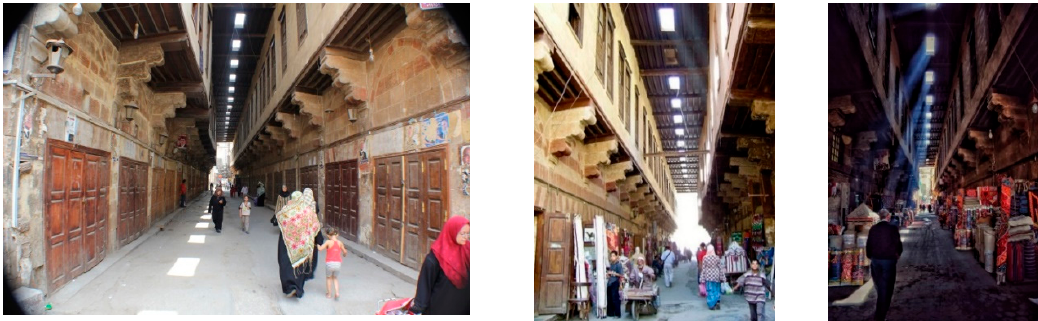
Figure 1. Al Khayamiya Alley. Ancient town planners tried to avoid direct exposure to intense solar radiation.